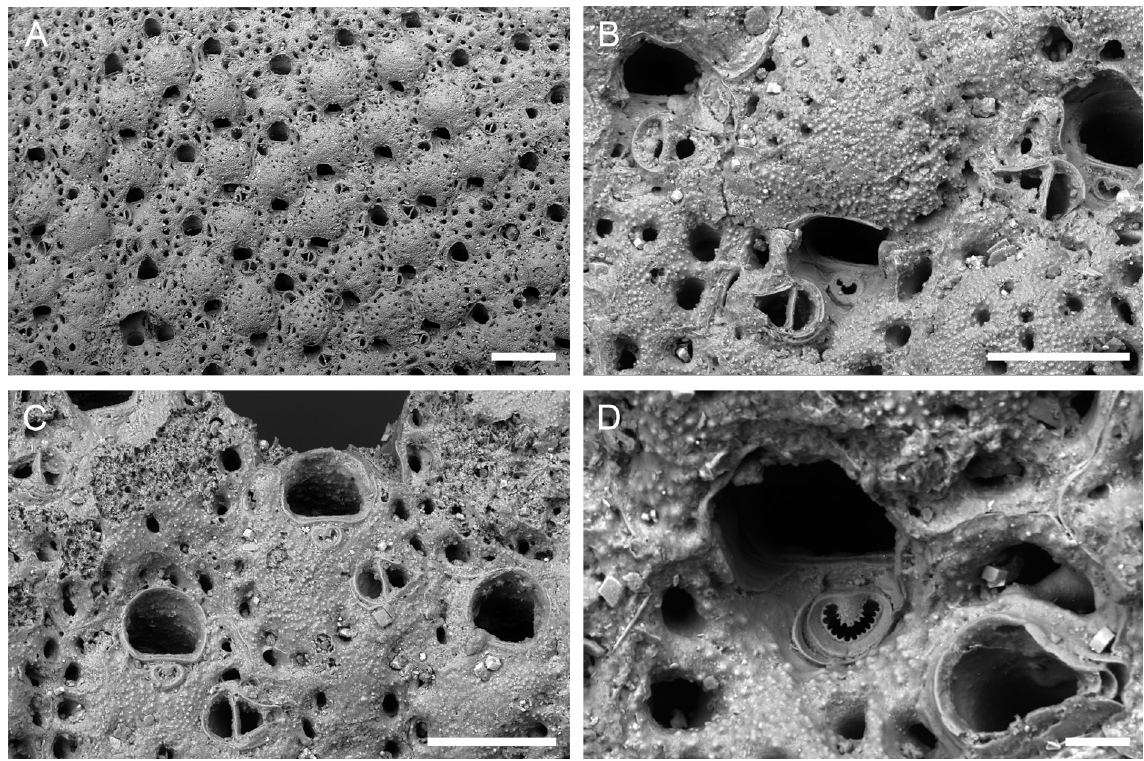
Fig. 3. Microporella tanyae sp. nov., holotype, NHMUK PI BZ 8890, Pliocene, Yorktown Formation, Virginia, USA. A . Group of ovicellate and non-ovicellate zooids. B . Close-up of an ovicell. C . Close- up of an autozooid. D . Close-up of the ascopore and avicularium with intramural buds. Scale bars: A = 400 µm; B–C = 200 µm; C = 200 µm; D = 40 µm.